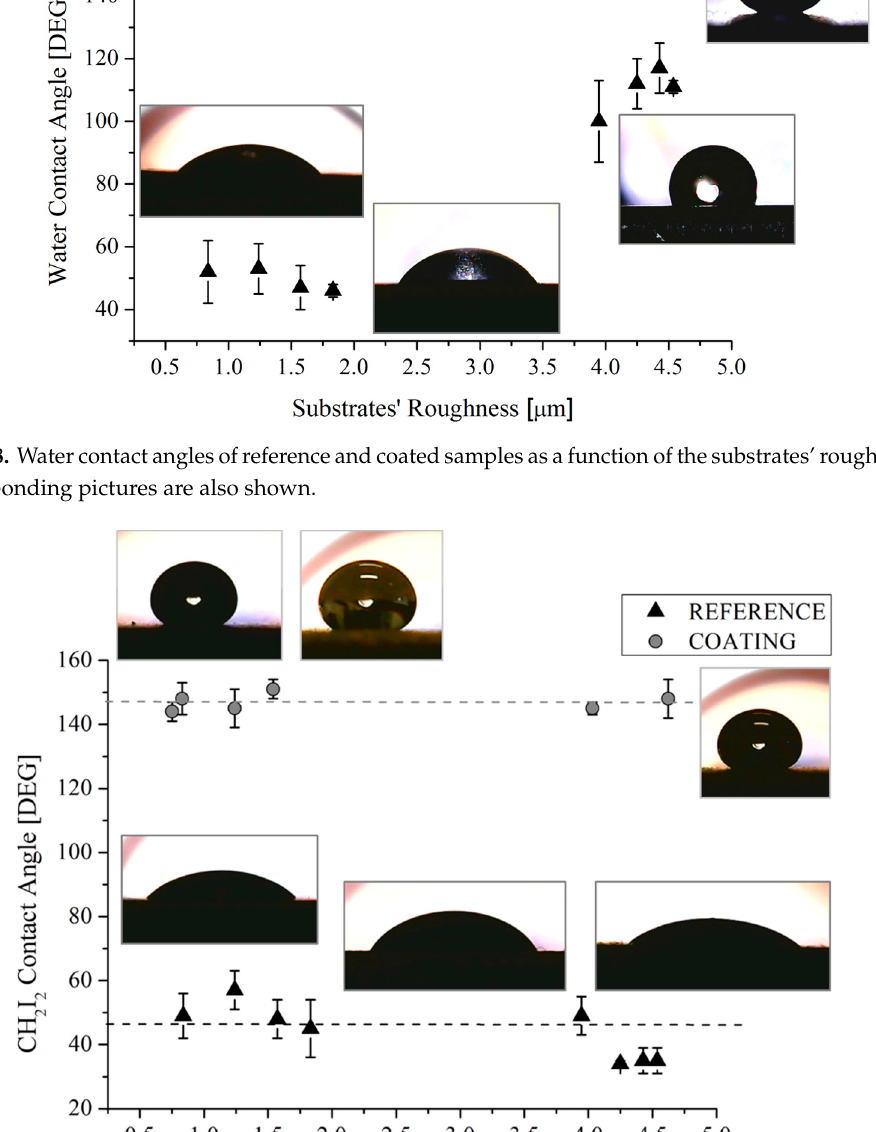
Figure 10. SFE and W A of the uncoated ( a ) and coated ( b ) samples as a function of the roughness. It was found that the solid SFE of the reference samples varies between 44 and 54 mN/m, for roughness values ranging from 0.7 to 2 µm, whereas for roughness of 4 µm the SFE becomes 38 mN/m (Figure 10a). Similarly, the W A varies between 108 and 122 mN/m, assuming a value of 69 mN/m for the sample at 4 µm in roughness. For samples having roughness higher than 4 µm, results cannot be achieved without taking into account the actual surface roughness, e.g., through Equations (12),(13), or more complex relationship, i.e., those described in ref. [33]. Indeed, it was found that roughness higher than 4 µm the Equations’ system (4) did not give a solution, so no intersection of the two curves can be observed in graphs of Figure 11b. On the contrary, for lower values of the contact angles, the Equation system (4) reached solutions, as shown in Figure 11a as an example.